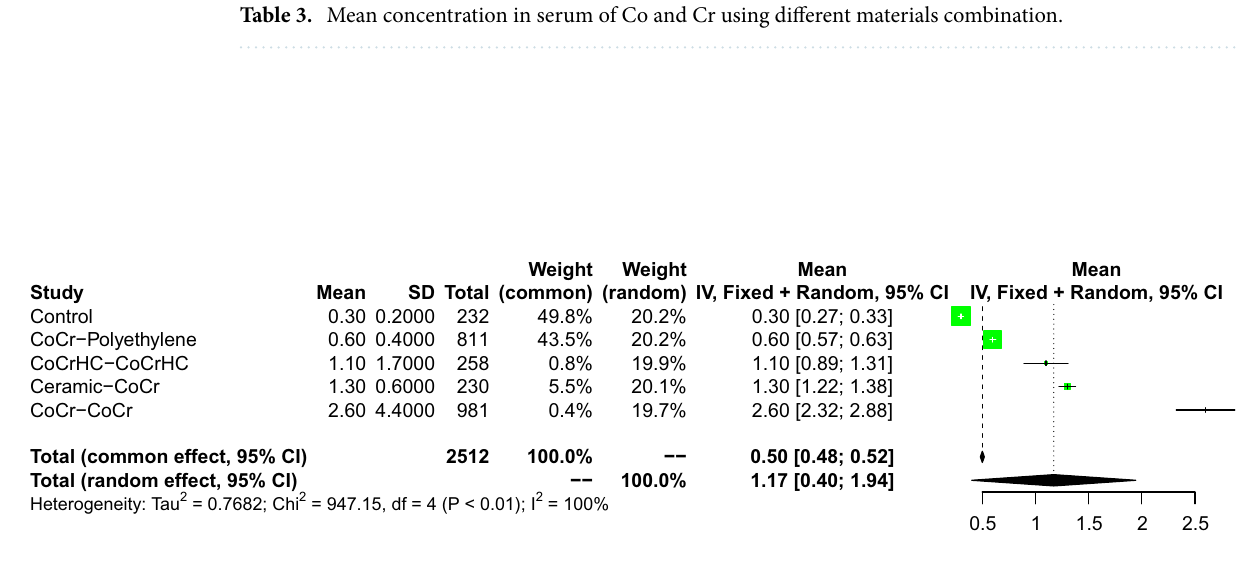
Figure 3. Forest plot of the comparison on